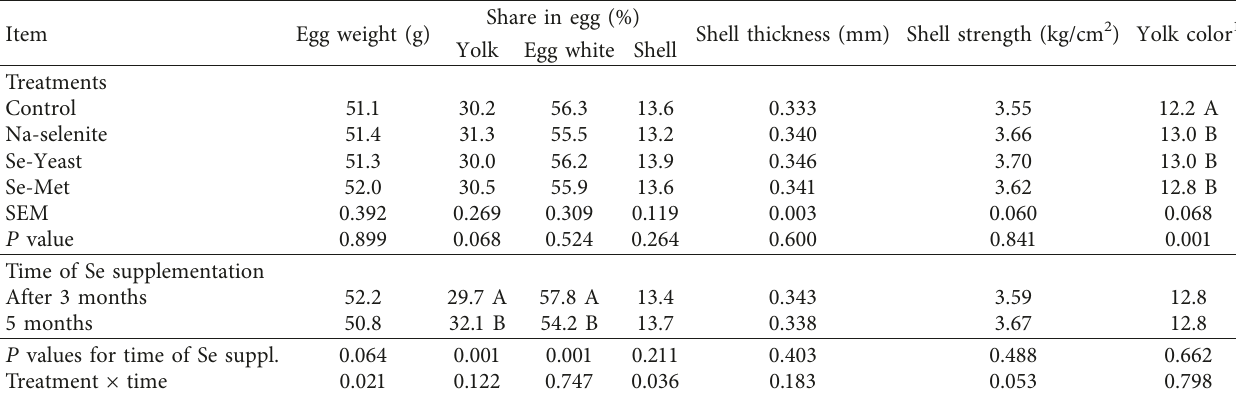
Table 4: Effects of dietary selenium supplements on egg characteristics.